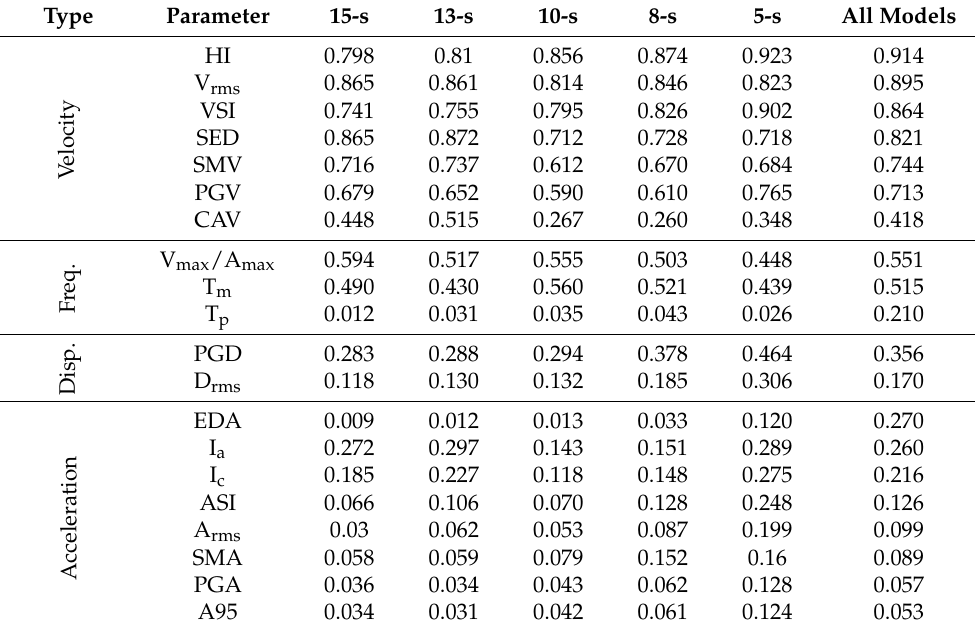
Table 8. Correlation (R 2 value) of parameters with roof drift ratios of models for buildings with different number of floors.